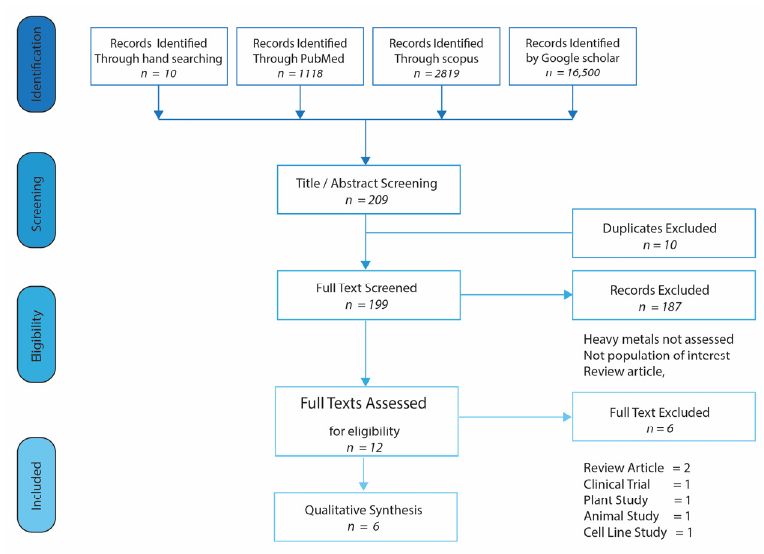
Figure 1. Flow Chart of Included Studies for Systematic Review.